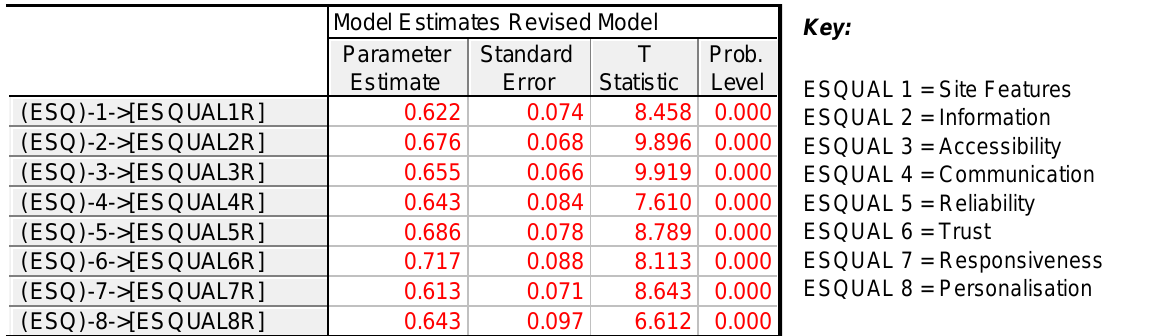
Table 2: Confirmatory analysis for the E-Service Quality Construct